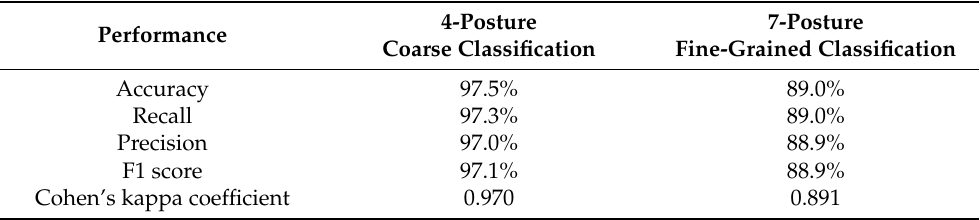
Table 1. Overall performance of 4-posture coarse-grained and 7-posture fine-grained classification model trained by convolution neural